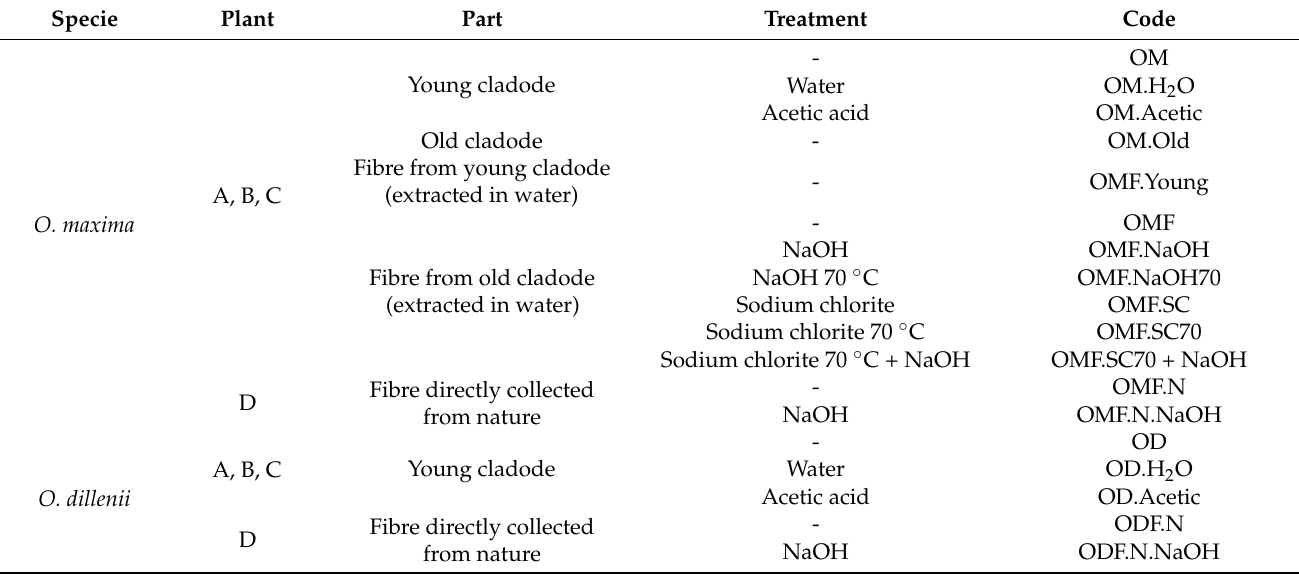
Table 1. Summary and identification of all Opuntia samples obtained.